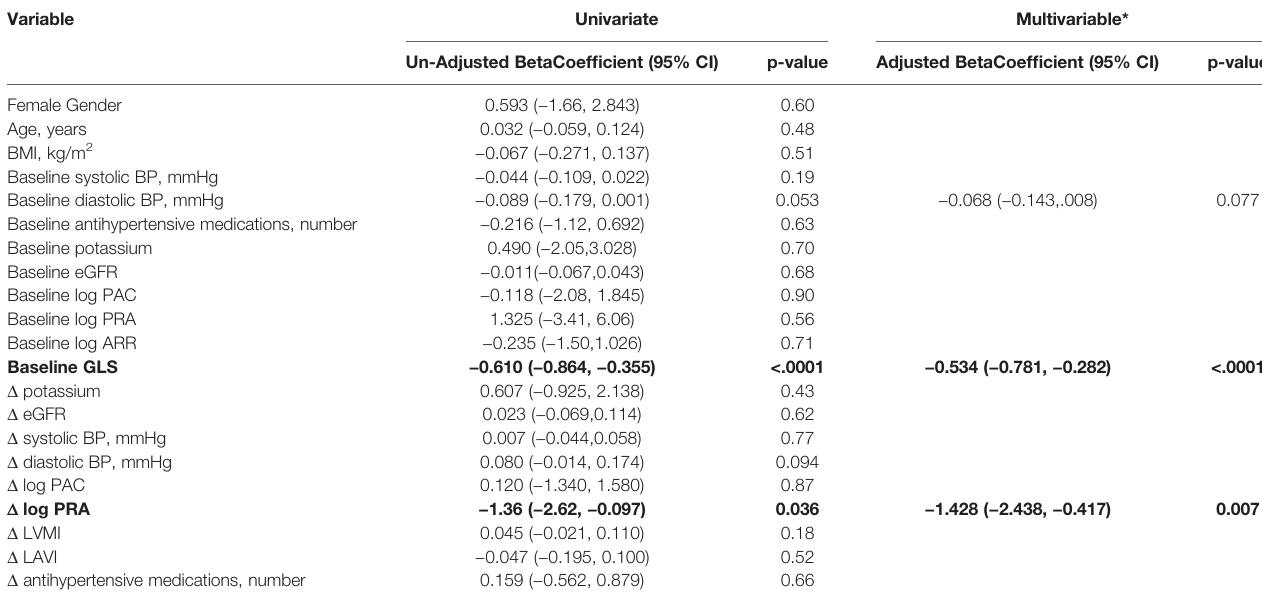
TABLE 3 | Univariate and multivariable linear model of D global longitudinal strain (GLS) before and after treatment in all patients treated for primary aldosteronism (n =